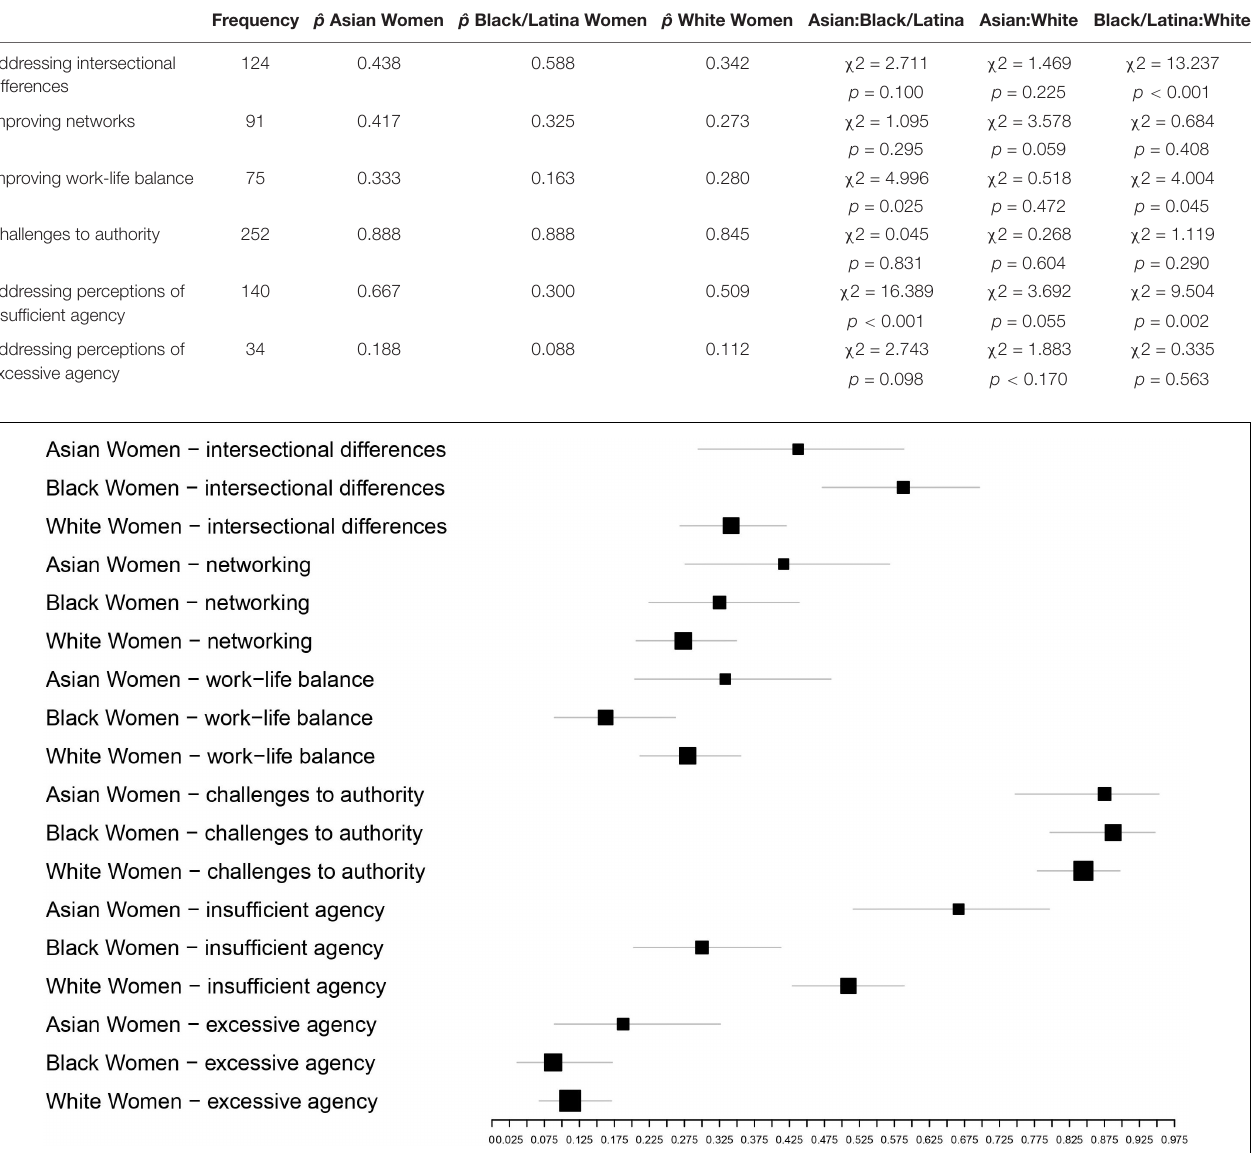
FIGURE 1 | Proportions of intervention needs as a function of racialized